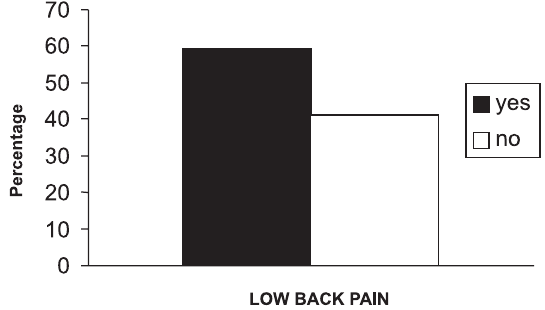
Figure 1 - Percent distribution of low back